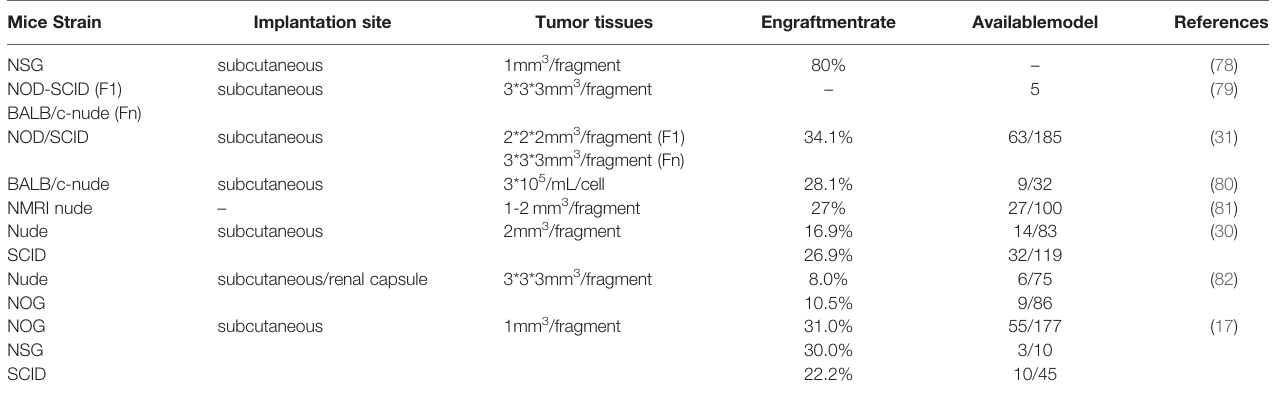
TABLE 1 | Summary of the success rates of GCPDX under different